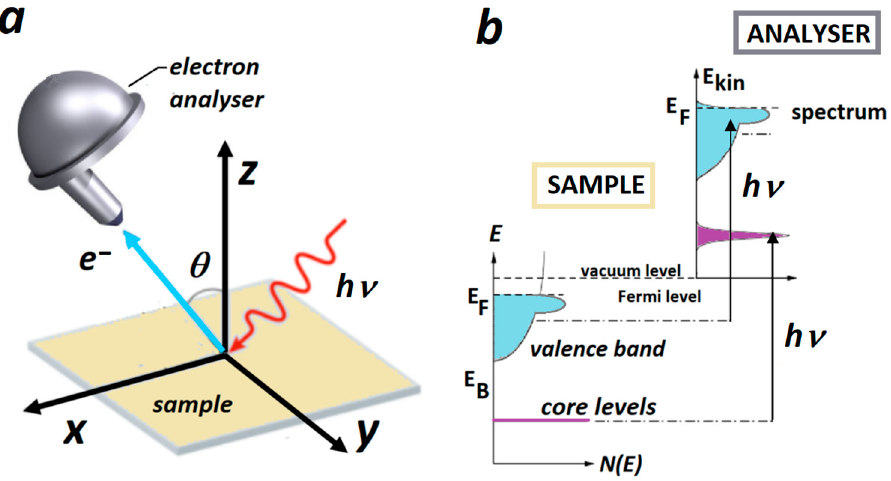
Figure 1. ( a ) Geometrical set-up of UPS showing incident light of energy h ν exciting electrons in the sample. The electrons are collected and analyzed by the electron analyzer; ( b ) schematic diagram of the valence band and core levels being excited by the light of energy h ν .